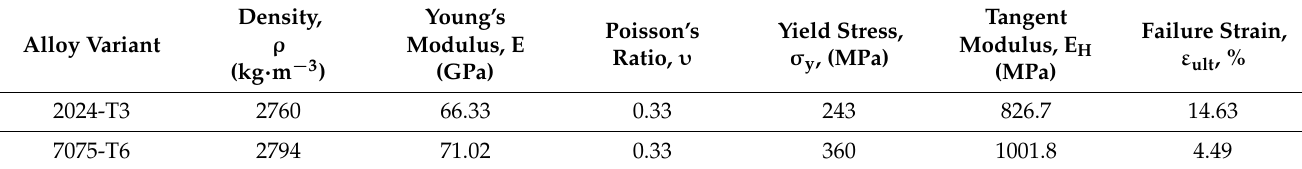
Table 1. Mechanical properties of Aluminum Alloy